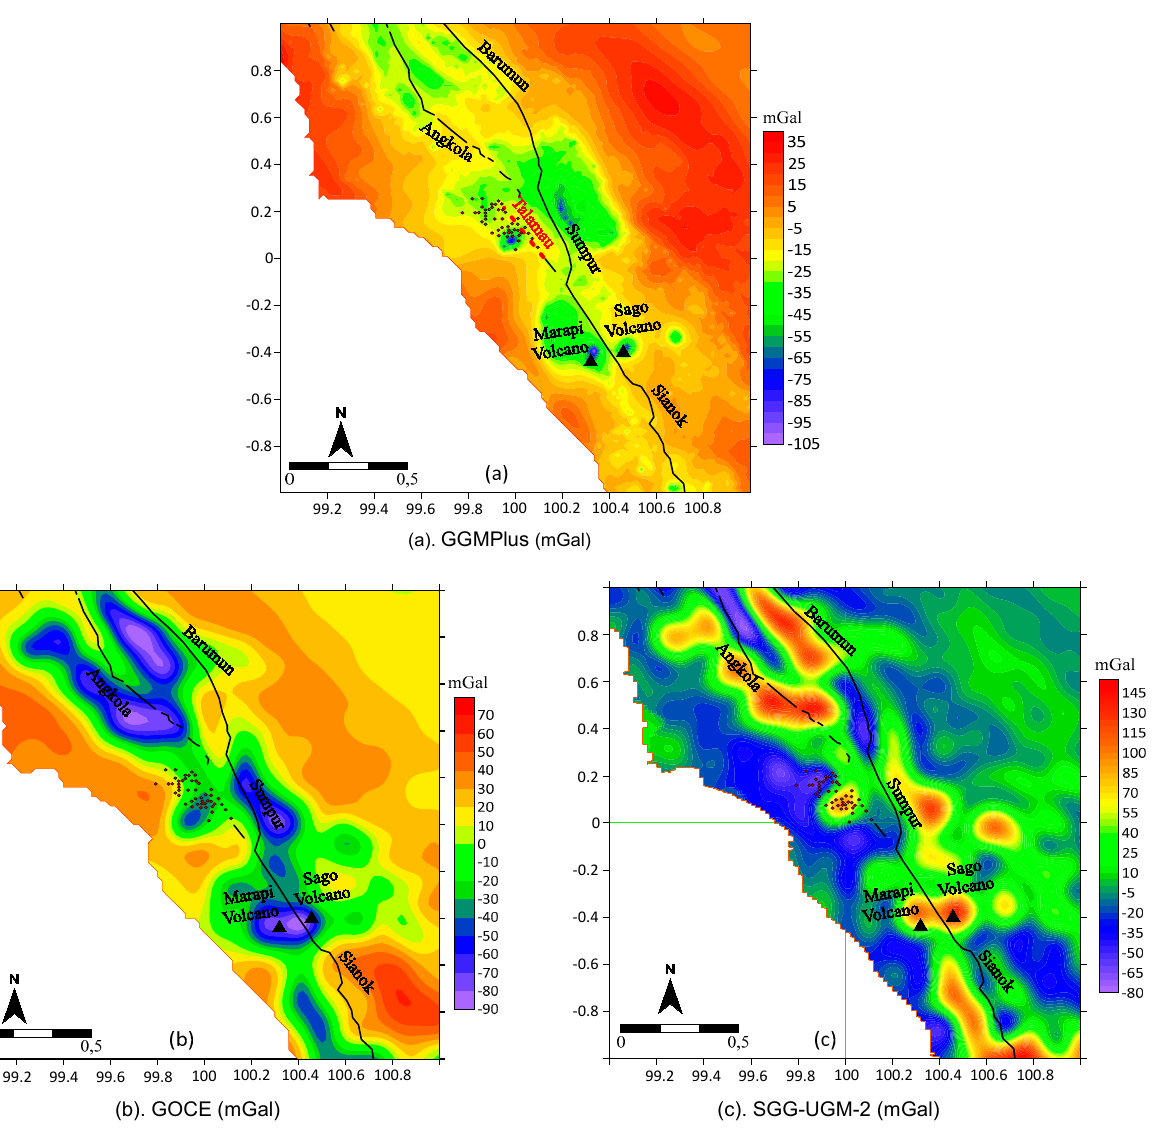
Figure 10. ( a ) GGMplus SBA, ( b ) GOCE SBA, and ( c ) SGG-UGM-2 SBA. Faults are symbolized by a black straight line, volcanoes are represented by a black triangle, a red dotted line symbolizes the inferred Talamau fault, and red dots illustrates aftershocks distribution.